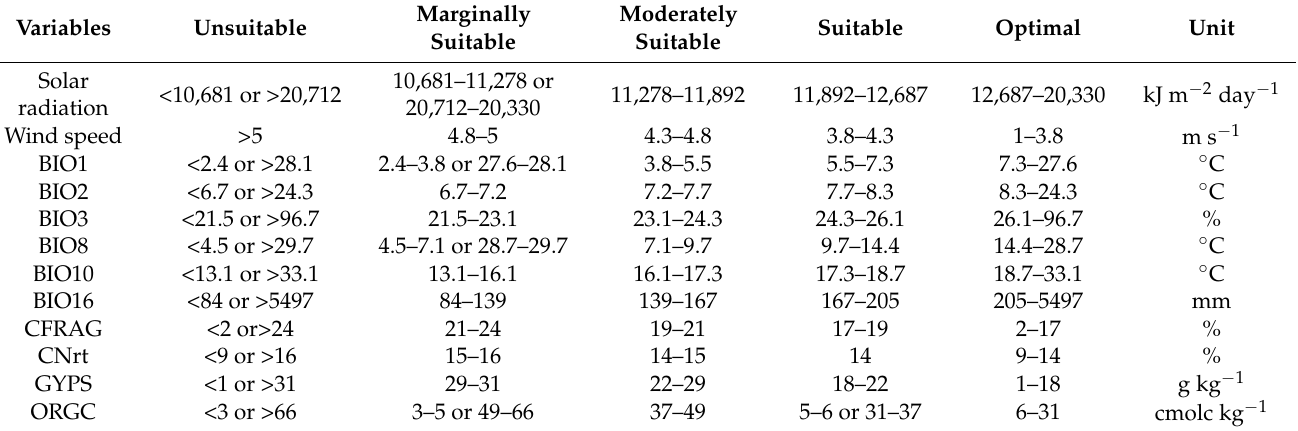
Table 2. Criteria designed for assessing the land suitability for maize cultivation